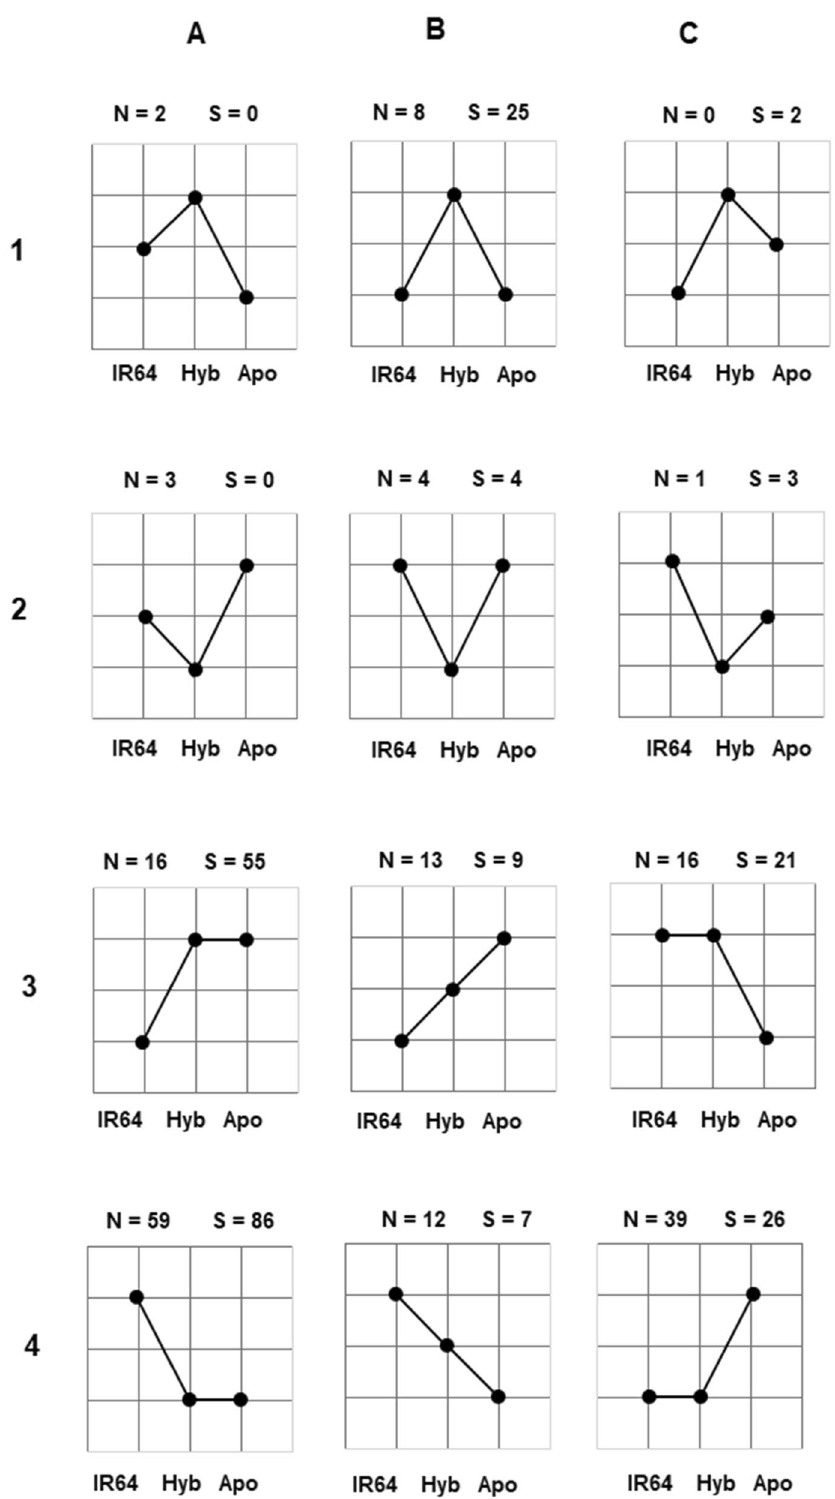
Figure 2. Two-dimensional grid node demonstrating expression performance of the F1 hybrids (Hyb) relative to its parents (Apo and IR64). Values above each panel indicate number of transcript isoforms under unstressed (N) and stressed (S) conditions exhibiting such mode of expression inheritance. Row 1 shows isoforms which exhibits over-dominance; 2, under-dominance; 3A and 4A, paternal (Apo) dominance; 3C and 4C, maternal (IR64) dominance; 3B and 4B, mid-parent or